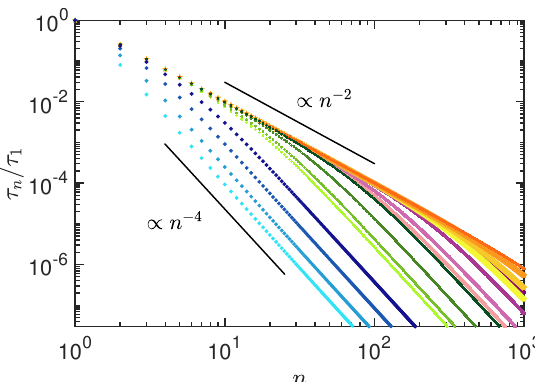
Figure 5. Mode-number dependence of the relaxation times τ n normalized by the longest relaxation time τ 1 for the Péclet numbers Pe = 0, 10 1 , 10 2 , and 10 3 (different colors and symbols; from left to right), and the Weissenberg numbers Wi = 0, 10 1 , 10 2 , and 10 3 (different tone, bright to dark, for every color). The persistence length is pL = 1 and L / l = 10 2